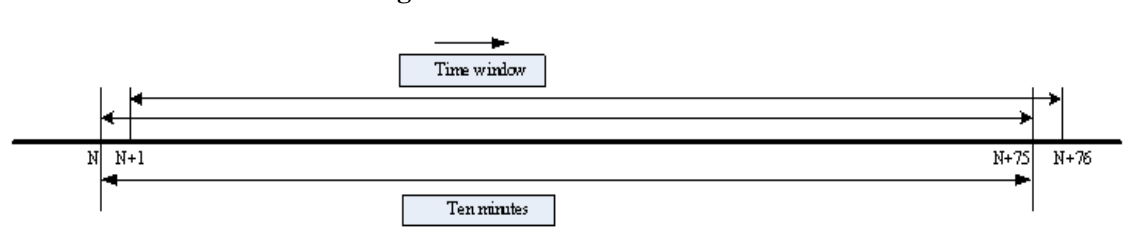
Figure 6. Time window method.